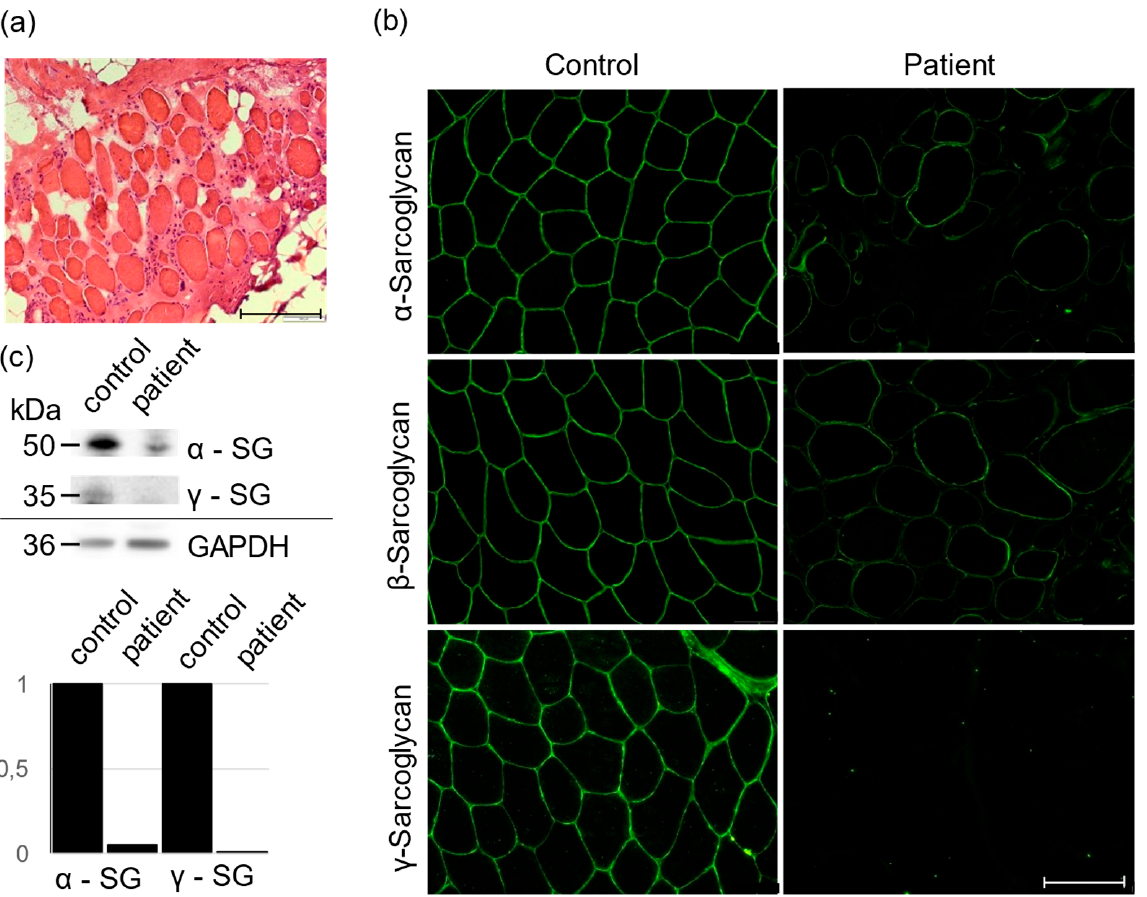
Figure 1. Haematoxylin and Eosin (HE) ( a ) and immunofluorescence staining with monoclonal antibodies ( α -SG Novocastra/Leica, β - and γ -SG/Novocastra) ( b ) of serial transverse cryosections. Muscle specimens from the patient ( a , b ) and an unaffected control ( b ). In the patient, α - and β -SG were reduced, and γ -SG was completely absent. Scale bars, 100 µ m. ( c ) Western Blot data with quantification demonstrated drastically reduction of α -SG and absence of γ -SG in the patient compared to control.